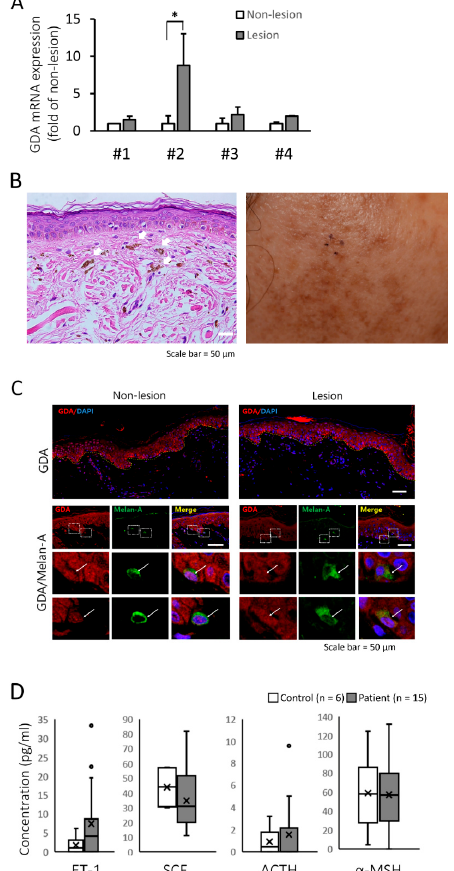
Figure 1. Guanine deaminase (GDA) expression in Riehl’s melanosis (RM) skin tissue. ( A ) Relative mRNA expression of GDA in lesional skin compared with that in non-lesional skin tissues from each patient with RM (n = 4). ( B ) Histopathologic (left panel, hematoxylin and eosin staining, original magnification 400 × , dermal melanophages are indicated by white arrows) and clinical features (right panel) of a patient with RM. ( C ) Immunofluorescence and immunohistochemical staining for GDA in non-lesional and lesional skin from a patient with RM. The images demonstrated GDA (red) with 4 (cid:48) ,6-diamidino-2-phenylindole (DAPI) (blue) as a nuclear counterstain (upper panel). Double immunofluorescence images for GDA (red), Melan-A (MART-1; melanocyte marker; green). Merged images with DAPI (blue) showed GDA and Melan-A double positive cells (white arrow; lower panel, scale bar = 50 µ m). ( D ) Box plots displaying the minimum, the maximum, the median, and the first and third quartiles for serum endothelin-1 (ET-1), stem cell factor (SCF), adrenocorticotropic hormone (ACTH), and alpha-melanocyte-stimulating hormone ( α -MSH) levels in patients with RM (n = 15) and age-matched healthy volunteers (n = 6). * p <